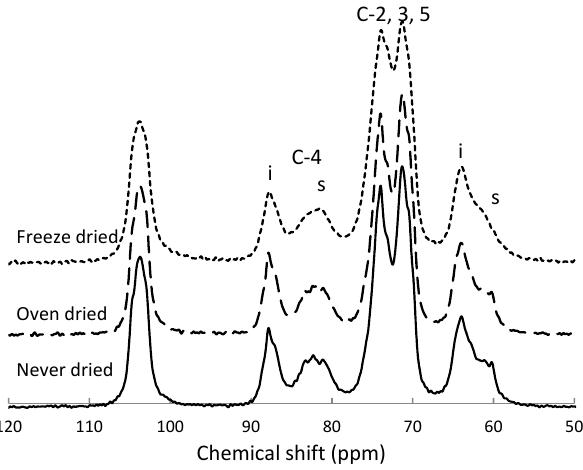
Figure 3. 13C solid-state NMR spectra of never-dried, freeze-dried and oven-dried pulps.